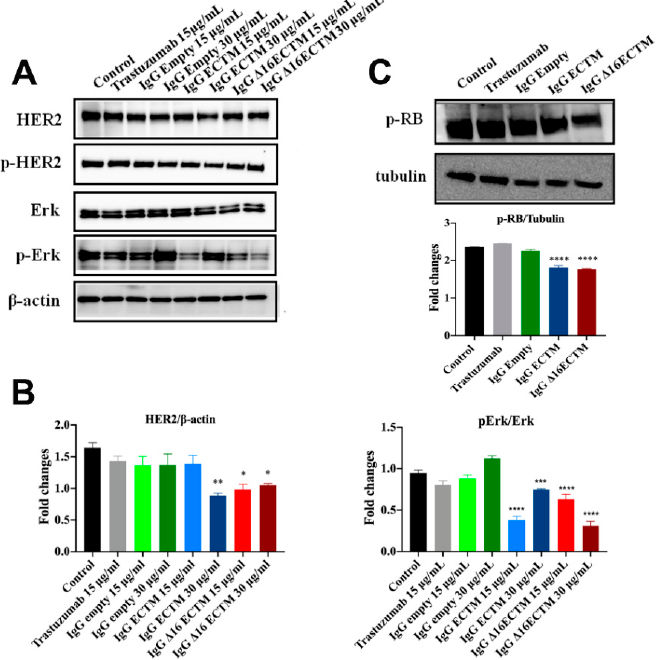
Figure 8. IgG purified from ECTM- and ∆ 16ECTM-immune sera impaired ERK activation in trastuzumab-resistant BT-474 BC cells. ( A ). Representative Western blot analysis of HER2 down- stream signaling pathways in trastuzumab-resistant BT-474 cells, treated or not with trastuzumab or control-IgG or immune-IgG at the indicated concentrations for 8 h. Expression level of HER2,